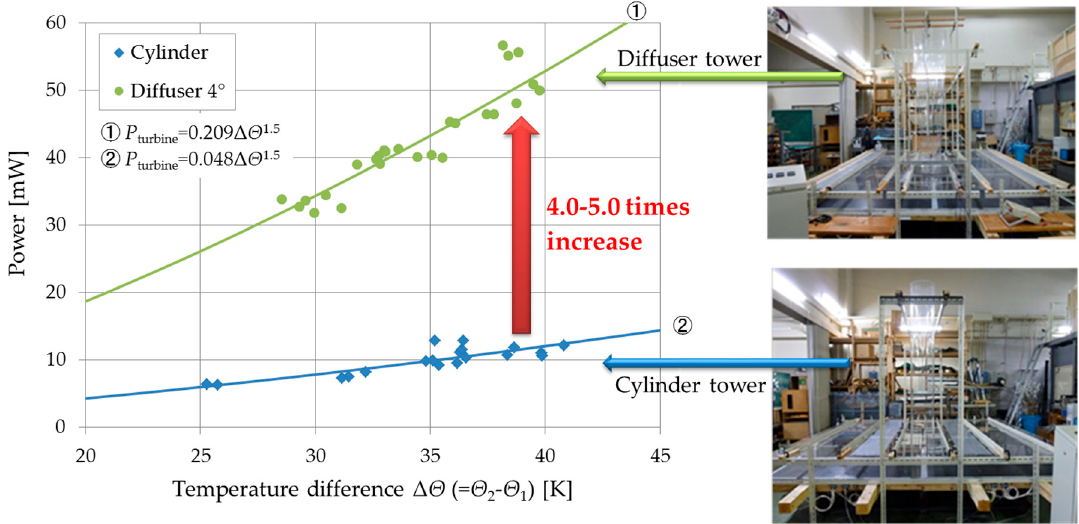
Figure 4. Power output of wind turbine installed near the bottom of a solar tower model vs. temperature difference ∆ Θ . Refer to Figure 5, which shows the same experimental setup.